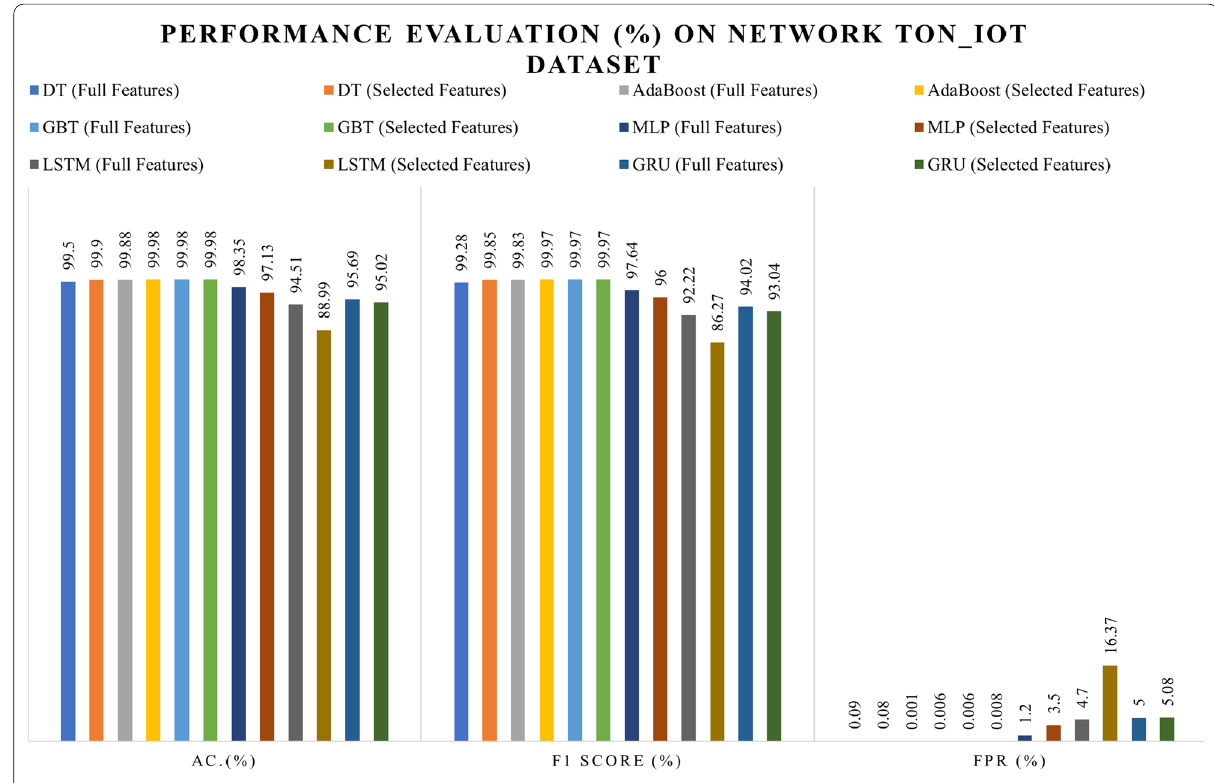
Fig. 9 The performance comparison between ML models with full feature and with reduced feature for Network TON_IoT